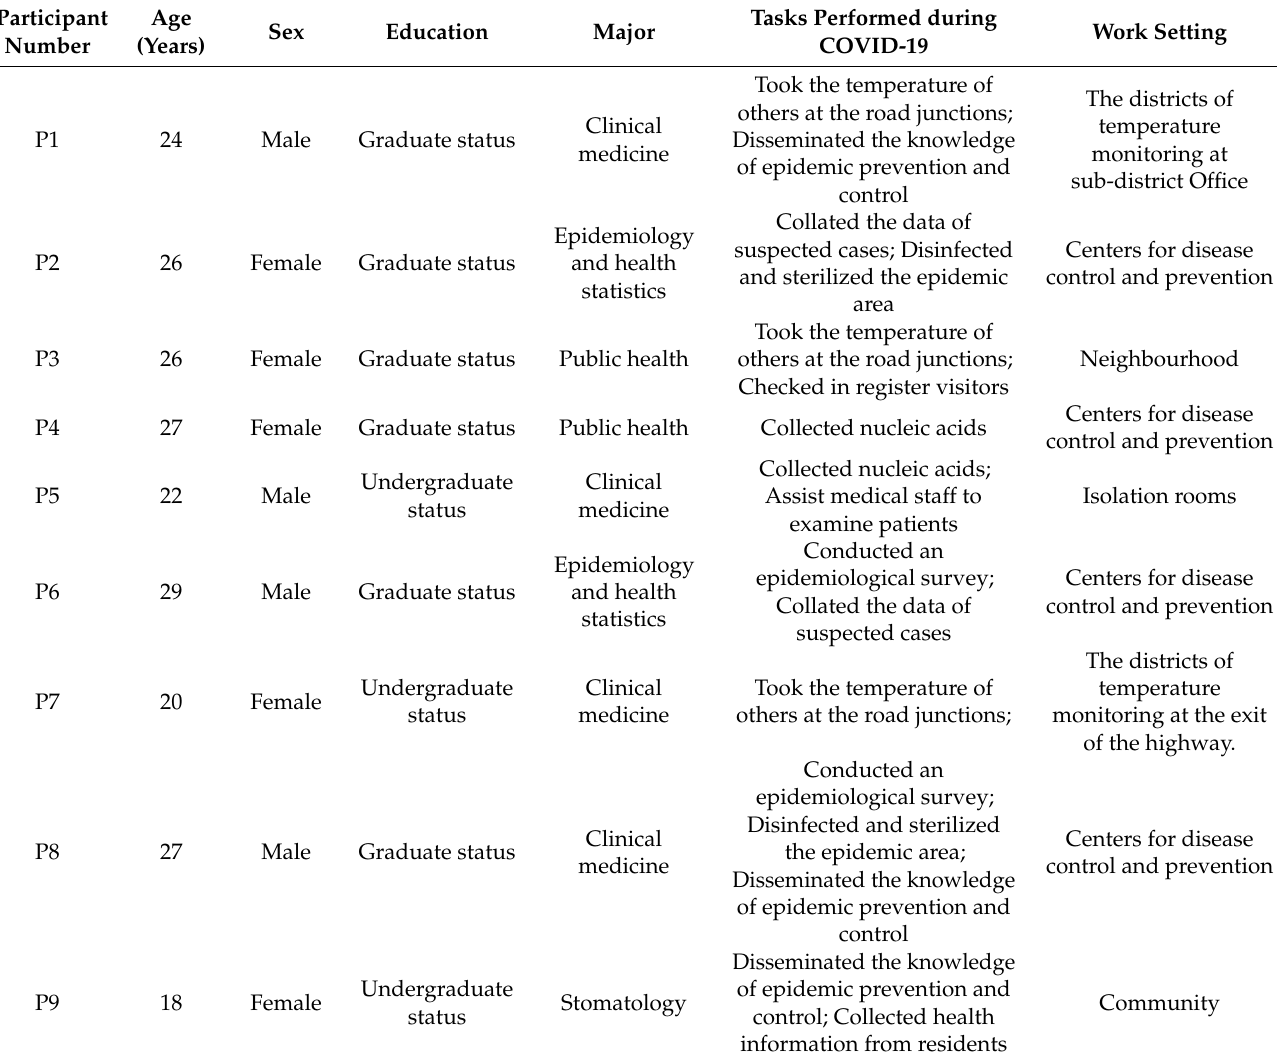
Table 2. The baseline characteristics of the participants.